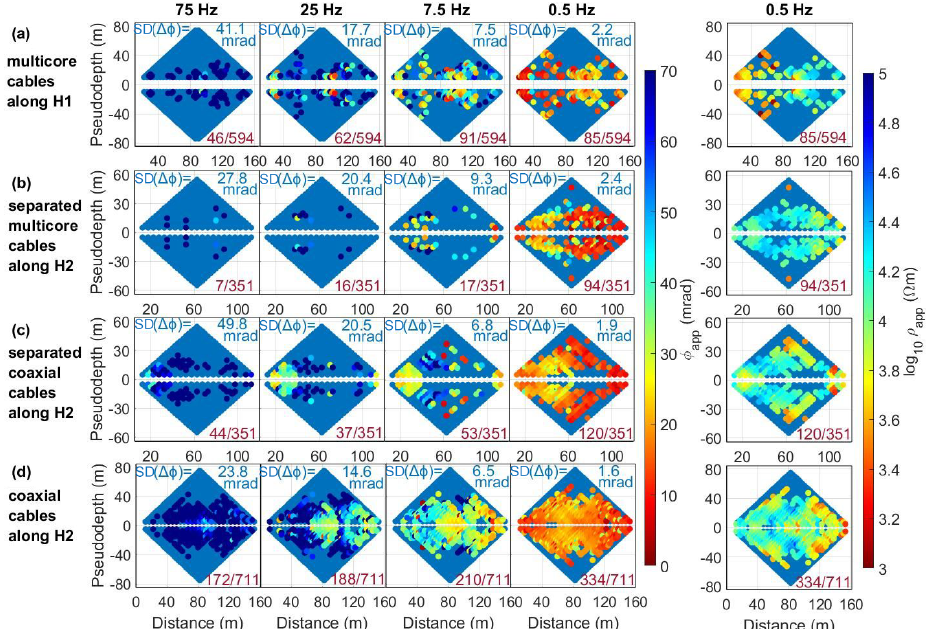
Figure 2. Pseudosections for normal and reciprocal data at four different frequencies (0.5, 7.5, 25 and 75Hz) collected at the Lapires site (a) along the PERMOS monitoring profile H1 (green line in Fig. 1, 43 electrodes with 4m spacing) using multicore cables, (d) along profile H2 (32 electrodes, 5m spacing) using coaxial cables and along the orange part of profile H2 (24 electrodes, 5m spacing) using (b) separated multicore cables and (c) separated coaxial cables. Pseudosections are presented before (blue symbols) and after (coloured symbols) the removal of outliers based on the misfit between normal and reciprocal readings (following Eqs. 22 and 23) indicated by a label on the right bottom of each subplot referencing the total and remaining number of N&R pairs. The standard deviation of the N&R misfit (SD ((cid:49)φ) ) is written in each plot for each frequency and cable setup.